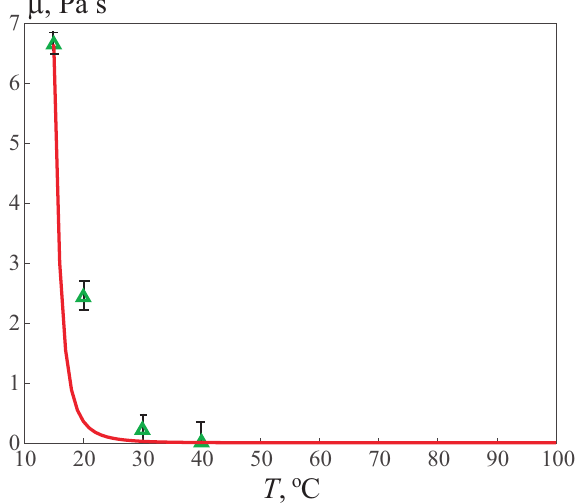
Figure 1. The dependence of the dynamic viscosity of oil from the Uzen field on temperature. Triangular symbols correspond to the experimental data [24], and solid line correspond to the calculations using the Walther